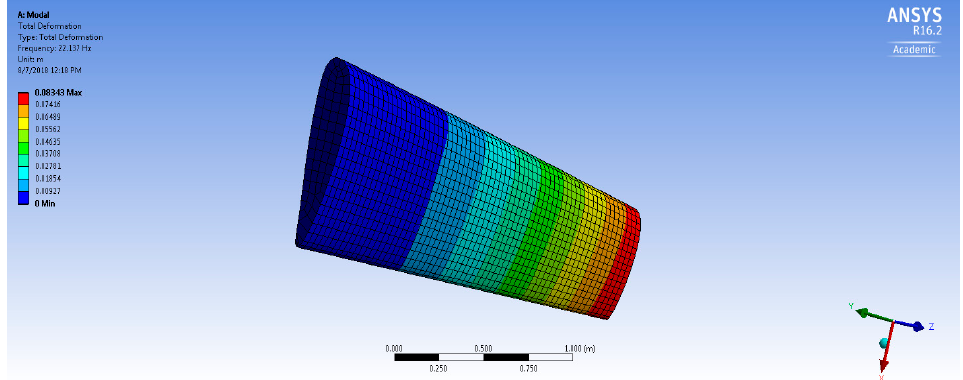
Figure 14. Computational vibrational modal analysis results: Al-alloywing.